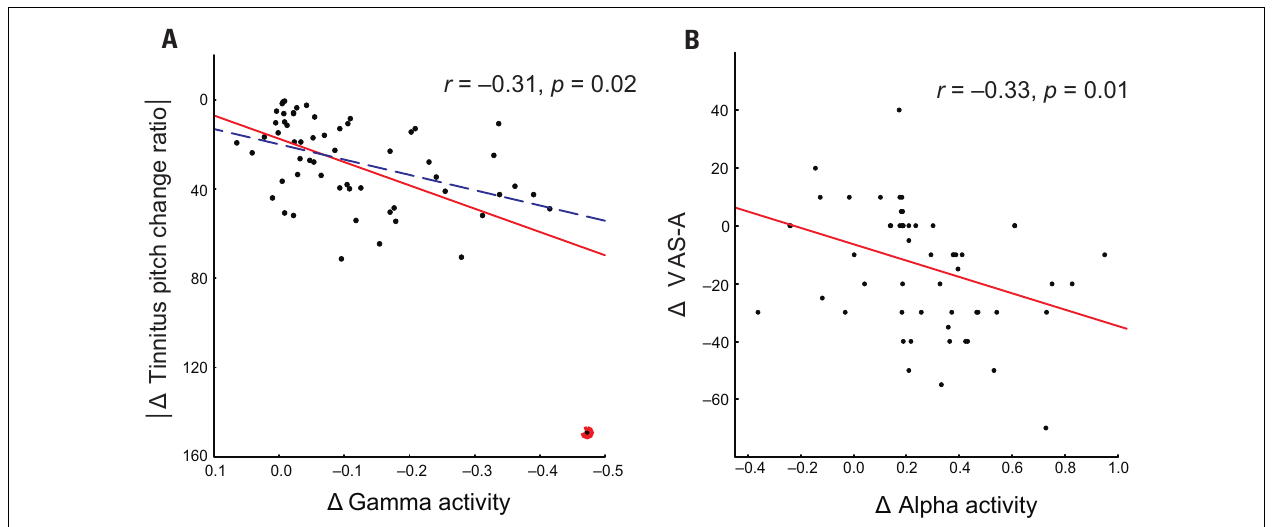
FIGURE 4 | Significant negative partial correlation between relative change of CSD gamma power and modulus of tinnitus pitch change ratio (A) with all patients included ( r = − 0.31, p = 0.02, solid red line) or with the outlier excluded ( r = − 0.29, p = 0.03, dashed blue line).The outlier patient is marked by the red circle. A significant negative correlation ( r = − 0.33, p = 0.01, n = 59) between relative change of anterior cingulate CSD alpha power and difference in VAS-A (B) .